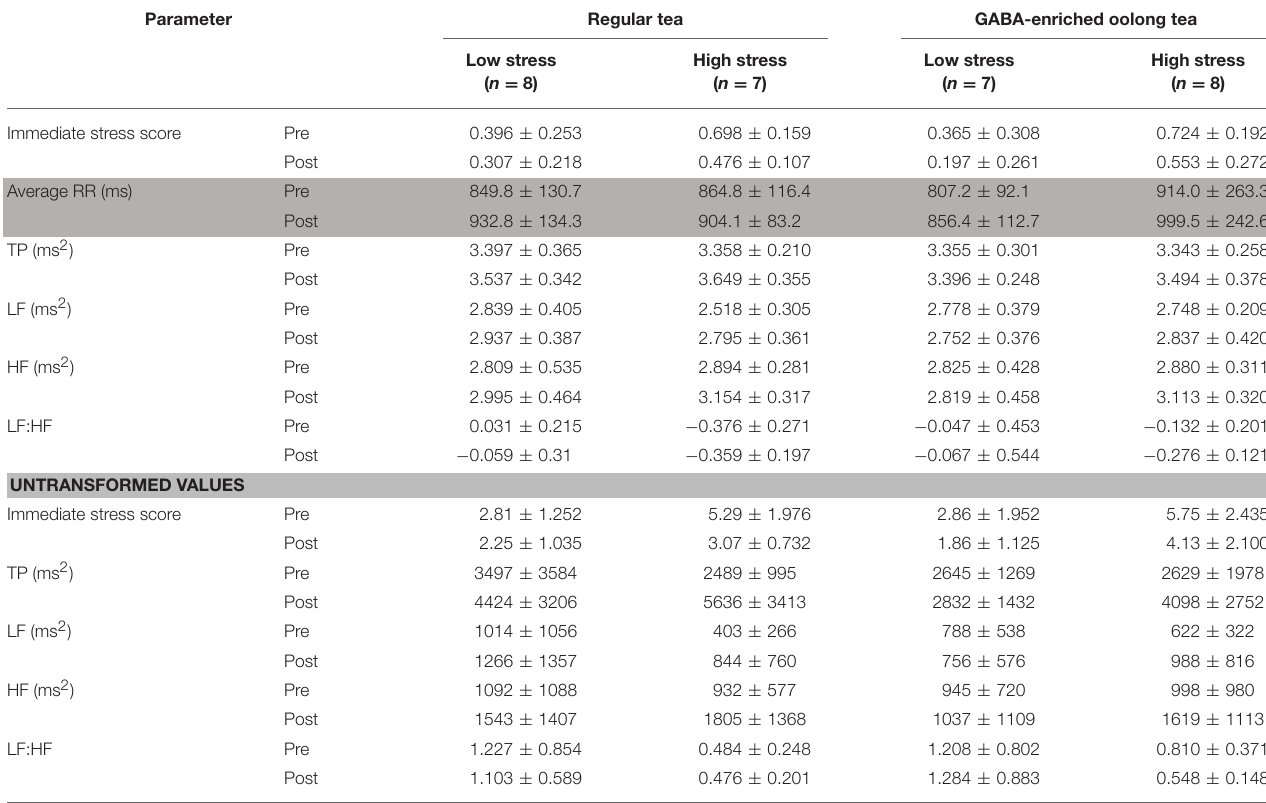
TABLE 3 | Psychological stress and heart rate variability parameters before and after ingestion of either GABA-enriched or control tea, separated by low, or high chronic stress